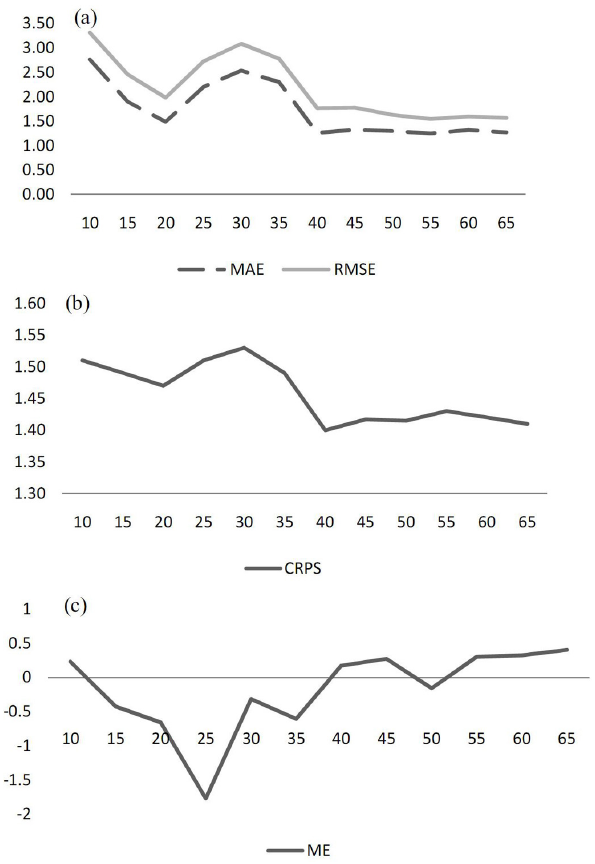
Fig. 2. Comparison of training period length for surface tempera- ture: diagram of (a) MAE, RMSE, (b) CRPS, and (c) ME for from 10 to 65 days.